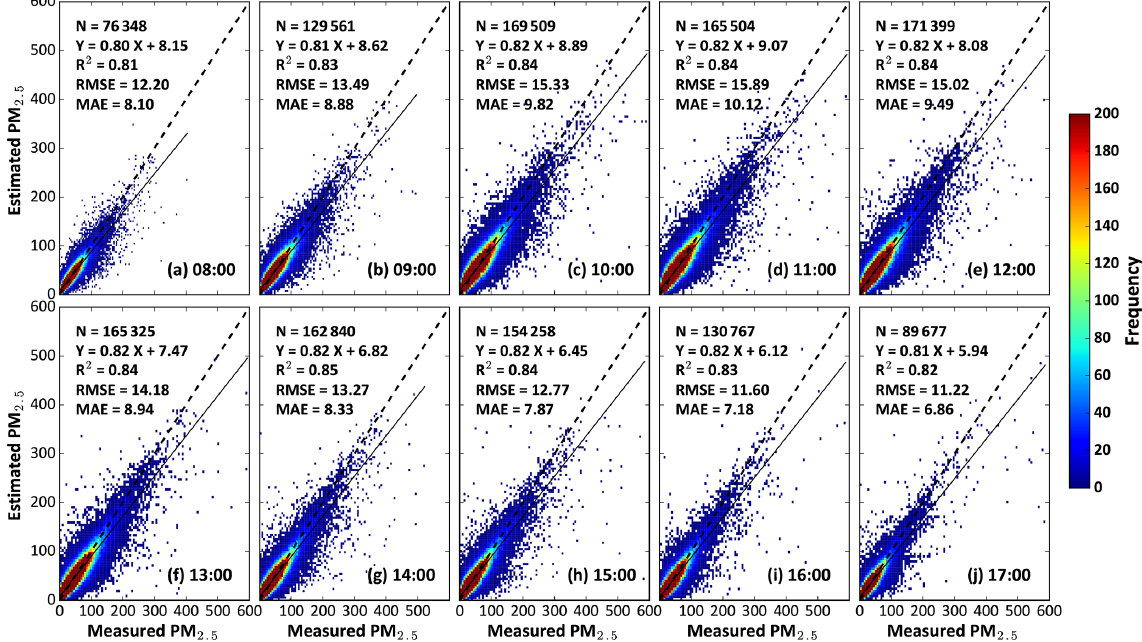
Figure 4. Density scatterplots of out-of-sample cross-validation results of PM 2 . 5 estimates (µgm − 3 ) at (a) 08:00LT, (b) 09:00LT, (c) 10:00LT, (d) 11:00LT, (e) 12:00LT, (f) 13:00LT, (g) 14:00LT, (h) 15:00LT, (i) 16:00LT, and (j) 17:00LT in 2018 in China. Dashed lines denote 1 : 1 lines, and solid lines denote best-fit lines from linear